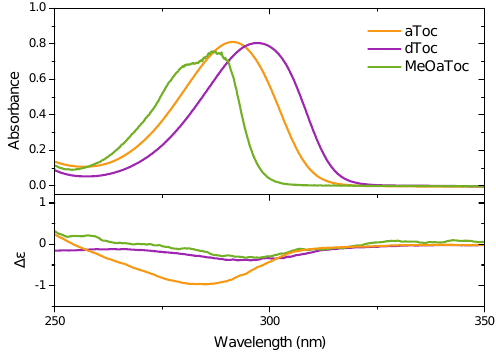
Figure 5. UV/vis spectrum (top panel) of aToc, dToc, and MeOaToc dissolved in methanol. The corresponding CD spectra are shown in the lower